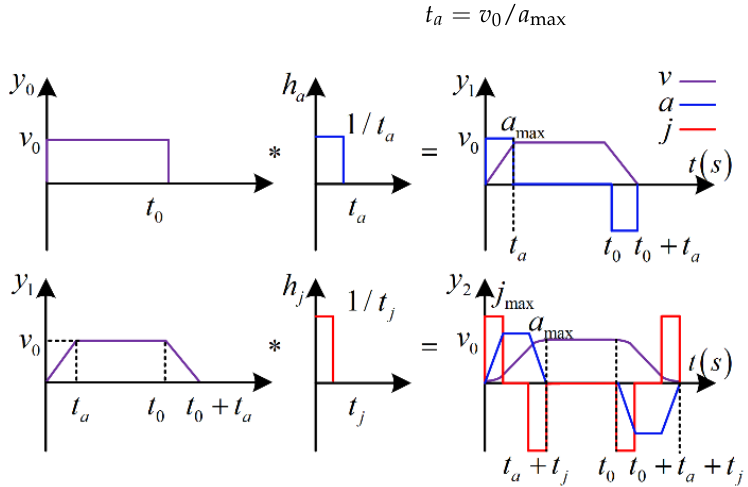
Figure 4. Principle of the convolutional dynamic-jerk-planning algorithm.